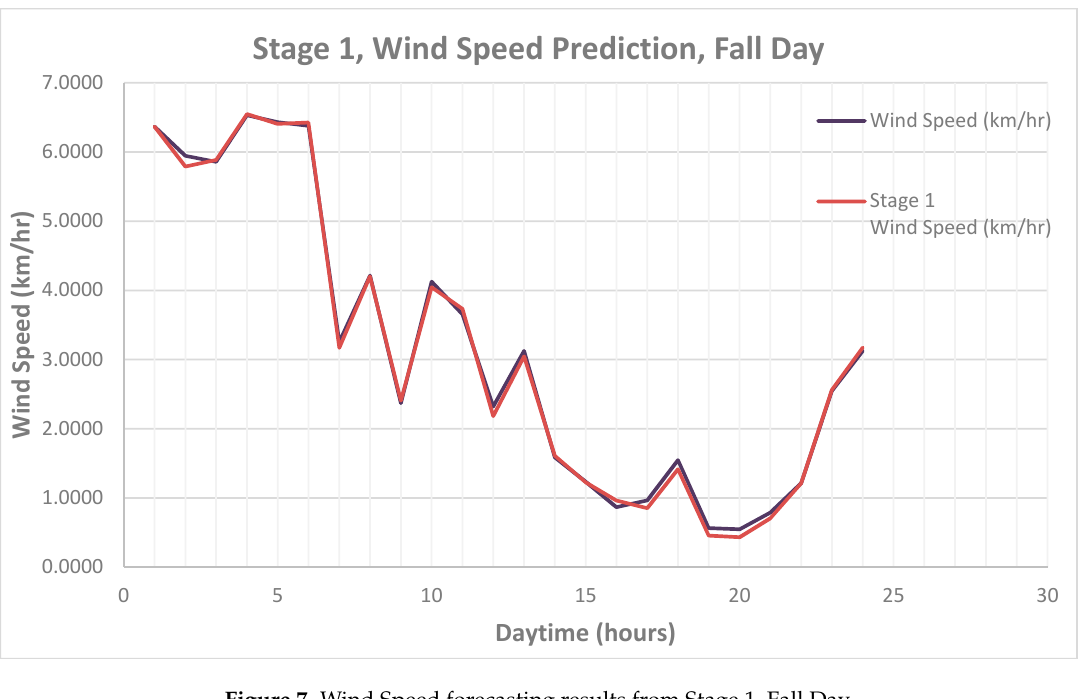
Figure 7. Wind Speed forecasting results from Stage 1, Fall Day.